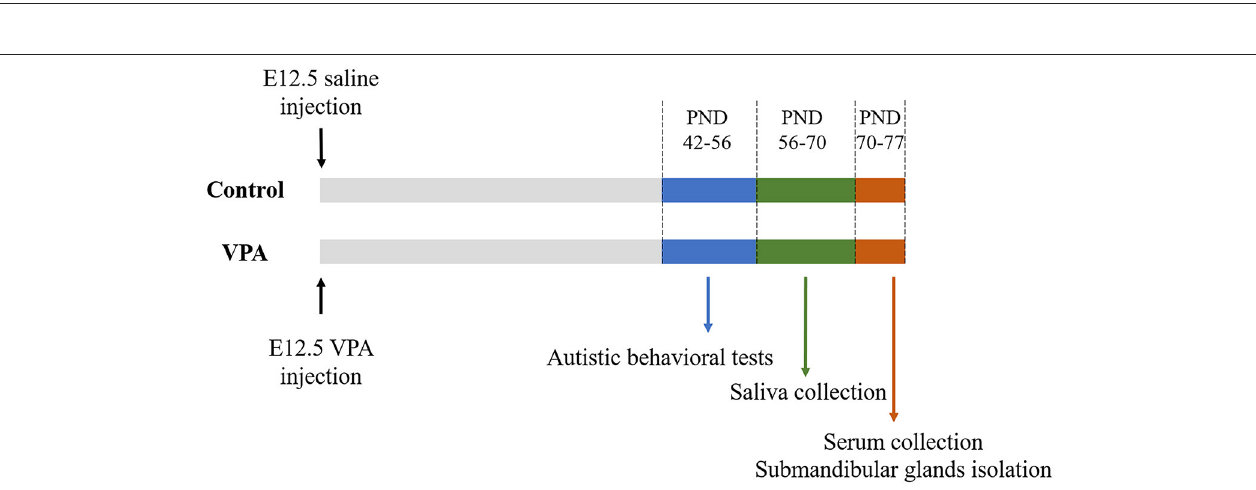
FIGURE 1 | Illustration of the formation of salivary IgA. IgA, immunoglobulin A; PIGR, polymeric immunoglobulin receptor.